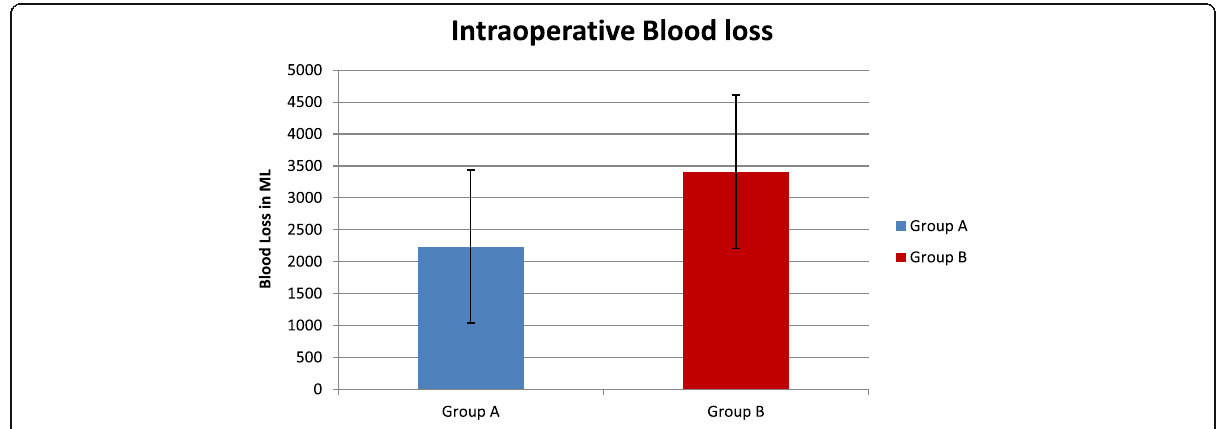
Fig. 1 The significant lower intraoperative blood loss in the TXA